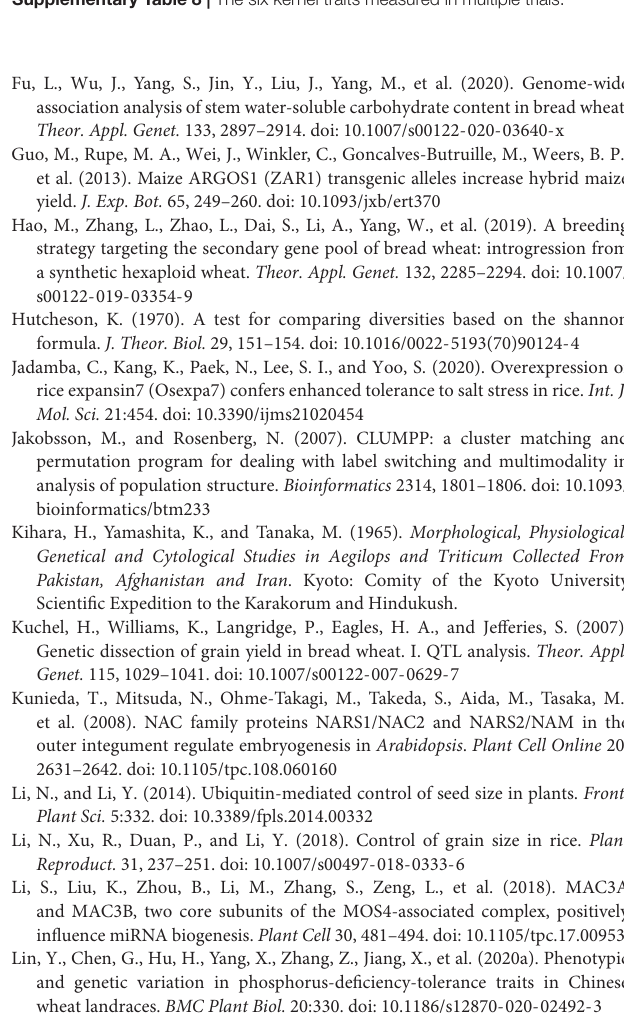
Supplementary Table 3 | Descriptive analysis, coefficient of variation of six kernel traits among environments. Supplementary Table 4 | Comparison of six kernel characters between T-group and S-group.